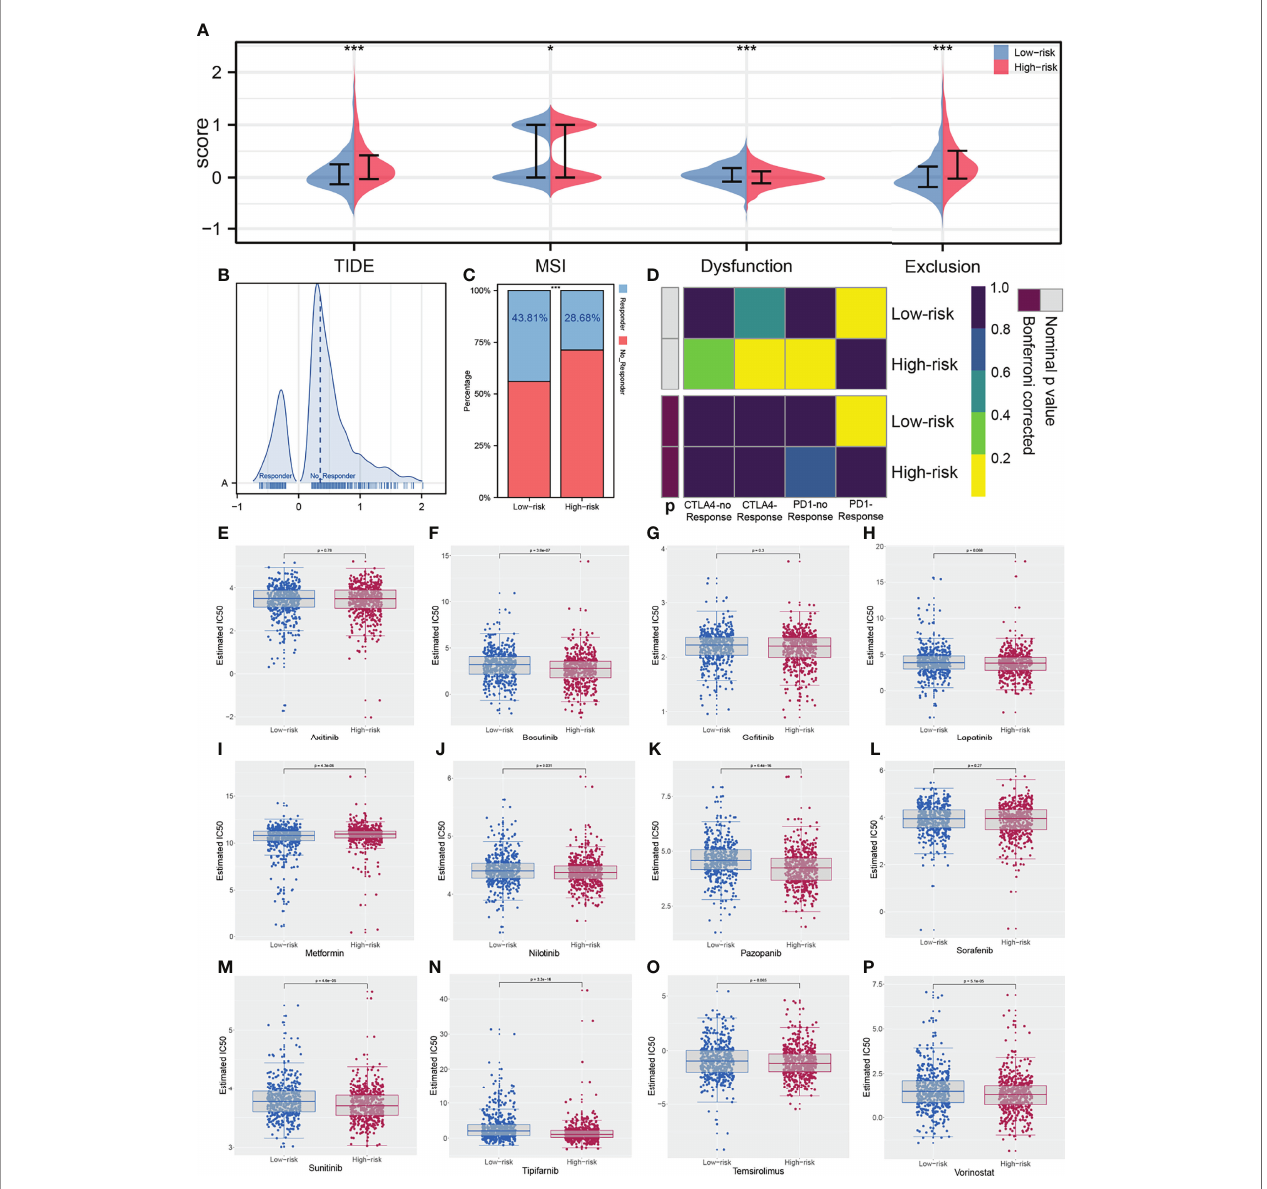
FIGURE 9 | Correlation of IRS immunotherapy response rate and drug sensitivity. (A) TIDE analysis was performed in enrolled patients; (B) The patients with TIDE score < 0 were de fi ned as immunotherapy responders, while > 0 were de fi ned as immunotherapy non-responders; (C) The high risk group had a higher percentage of immunotherapy non-responders; (D) The low risk group might more sensitive to PD-1 immunotherapy; (E – P) Drug sensitivity analysis was performed to explore the underlying in fl uence of IRS on common chemotherapy drugs. *P < 0.05, ***P <